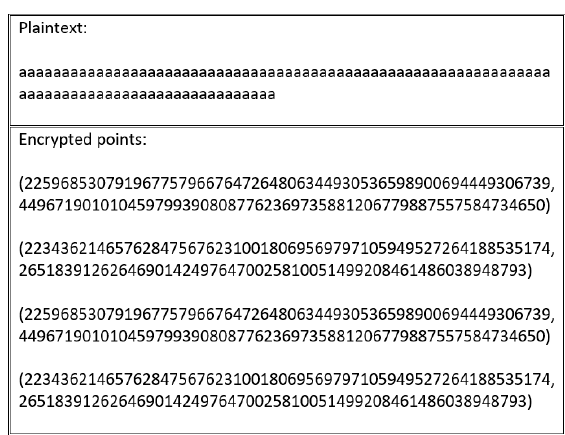
Figure 20. Cipher text generated via encryption of plain text, followed by XORing with InV using a special text that produces the same blocks.